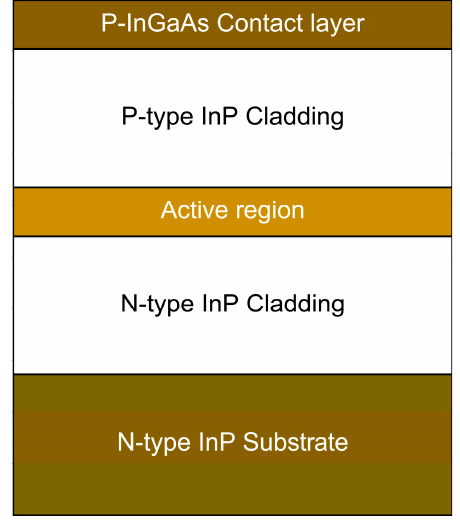
Figure 1. Laser structure.